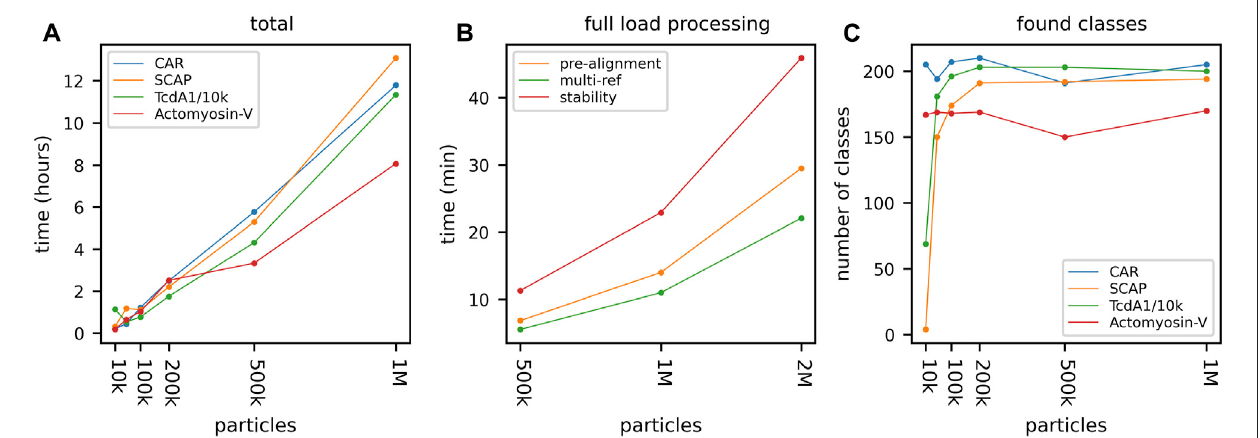
FIGURE 5 | CUDA kernel heavy load processing. Processing four data sets containing up to two million particles using two RTX 6000 cards. (A) Total processing time can be seen to scale linearly with the input size and processing of one million particles was completed within 8 – 12 h. (B) To demonstrate the performance of the GPUISACCUDAkernelsweshowthetimeneededtoprocess500,000,1,000,000,and2,000,000particlesofactomyosin-V,respectively.Shownareprocessingtimes during the fi rst ISAC iteration only, as this is the only time when the ISAC algorithm processes the full stack and no particles have been rejected, yet. Note that the pre-alignment includes fi ve repetitions of full-stack alignment, and stability testing includes fi ve repetitions of thirty times aligning all data with their designated class average,each.Asisshown,theGPUISACCUDAkernelsmanagedtorepeatedlyalign2,000,000particles150times(stabilitytesting)inlessthan40 min. (C) Bydefault, GPU ISAC is con fi gured to provide 200 classes. As can be seen, once more than 100,000 particles are being processed, GPU ISAC produces a full set of